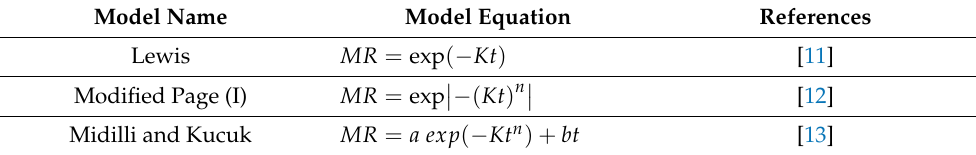
Table 1. Mathematical models used to describe the drying kinetics of leafy vegetables.